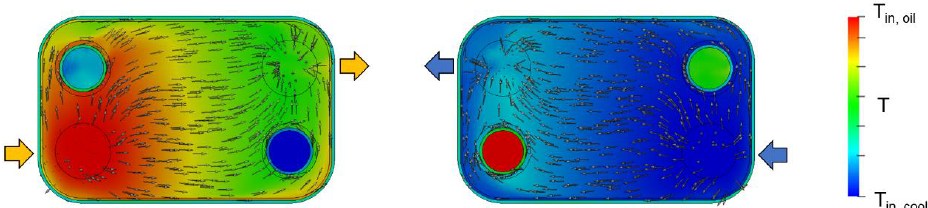
Figure 17. Cooler A: Temperature distribution across two transversal planes for oil and coolant passages, located in the middle of the heat exchanger. Flow direction is also reported. Operating conditions: Q oil = 50%, Q cool = 80%.